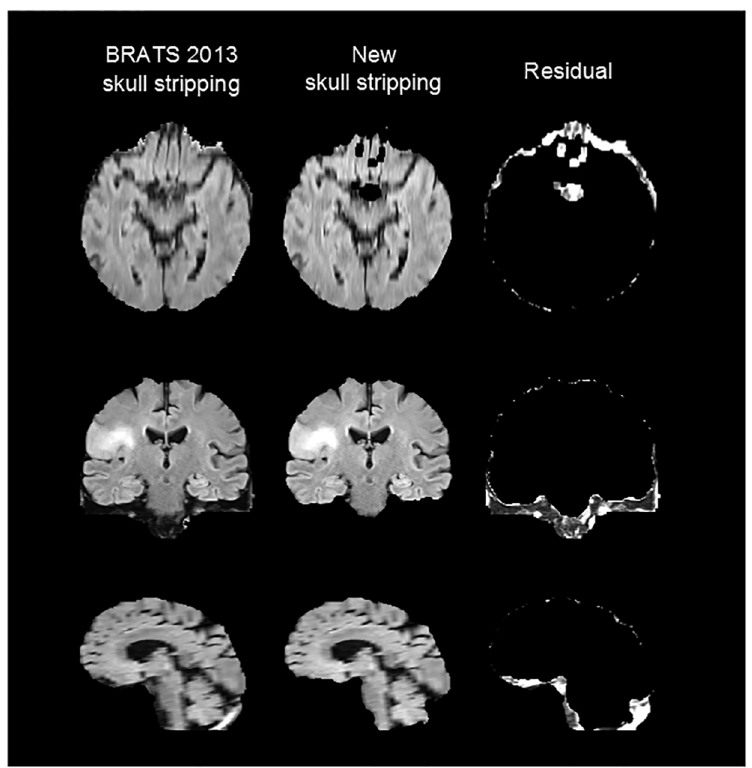
Fig 1. Example of new skull stripping. From left to right column: original BRATS 2013 patient image, resultant image after the new skull stripping and the remaining residual.